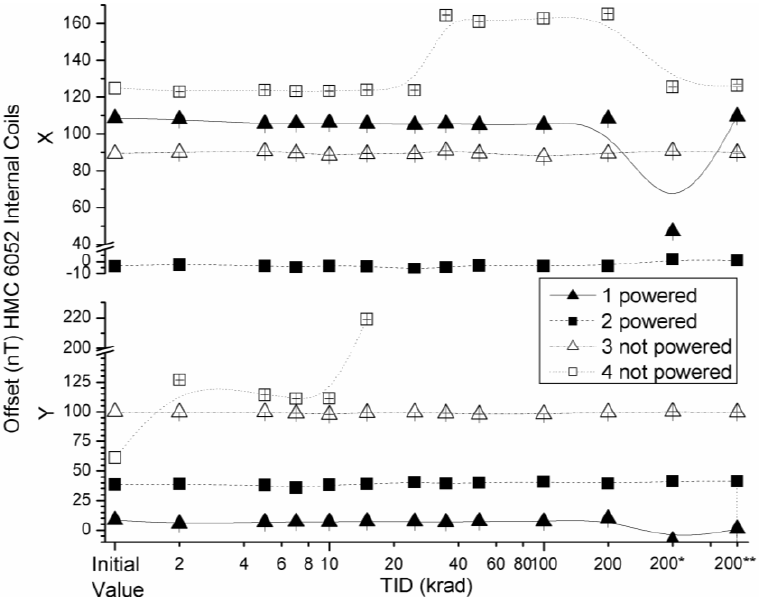
Figure 16. Measured offsets in internal coils configuration as a function of TID for powered and non-powered HMC